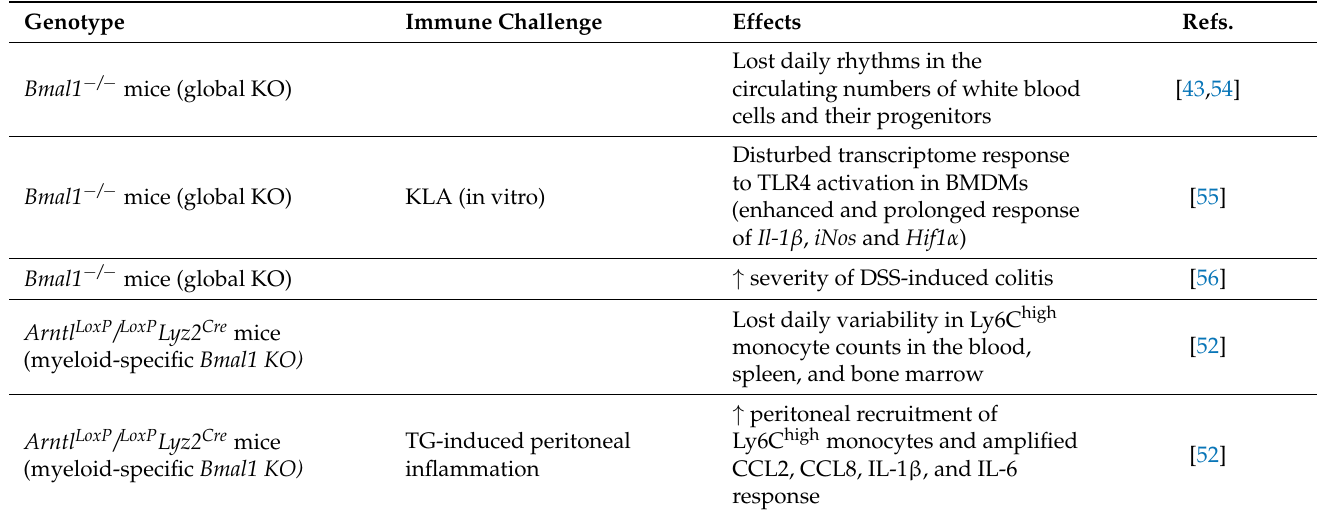
Table 1. Animal models with genetic disruption in specific clock components and their effects on processes related to innate immune functions and